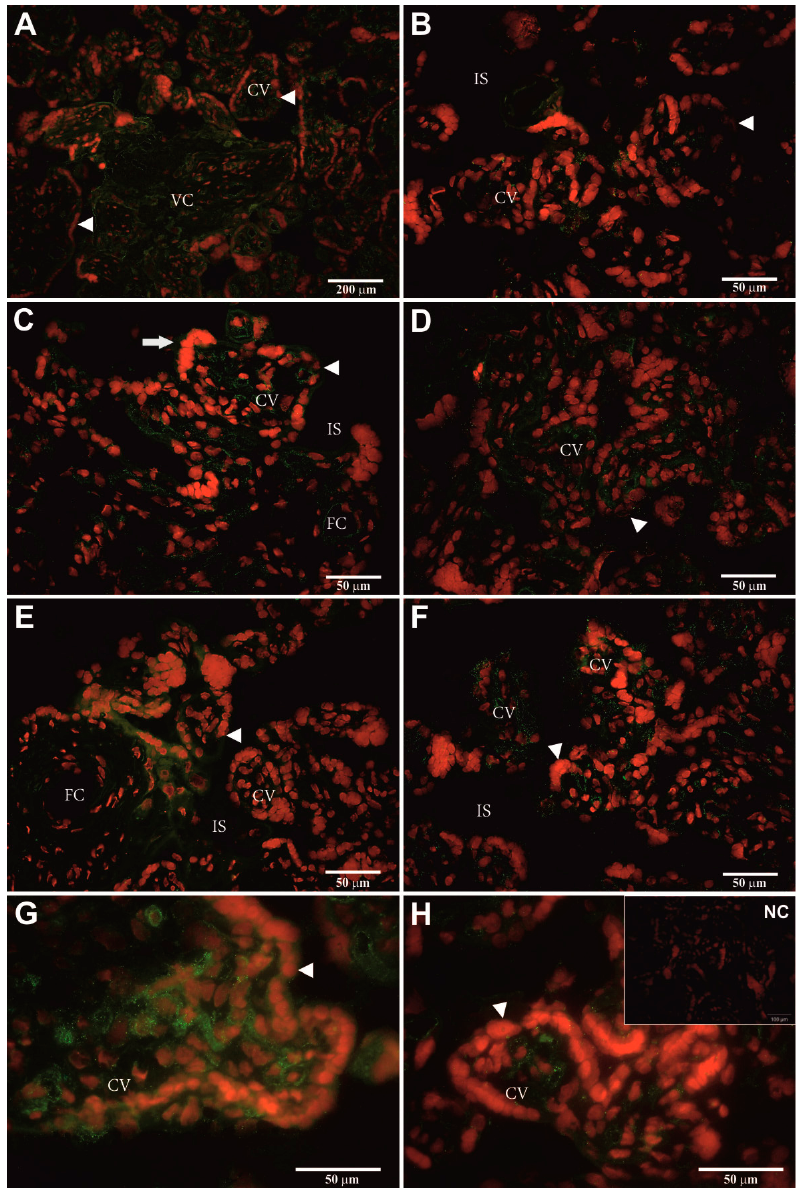
Figure 4. Heterologous immuno-localization of the hPAG-L/pep proteins within sections of a human term placenta identified with polyvalent anti-porcine PAG (anti-pPAG-P) polyclonals ( A – H ), visualized by goat anti-rabbit IgG-conjugated with Alexa 488 fluorophore (green) among all nuclei stained by propidium iodide (red). Human placenta section—used as negative control (NC; insert in H) with omitted polyvalent anti-pPAG-P polyclonals. The size bars are 50 µm ( B – H ), 100 µm (NC) and 200 µm ( A ). Abbreviations: arrowheads—syncytiotrophoblast; arrows—clusters of the syncytiotrophoblast nuclei; CV—chorionic villi; VC—villous core; IS—intervillous space; FC—fetal capillary.